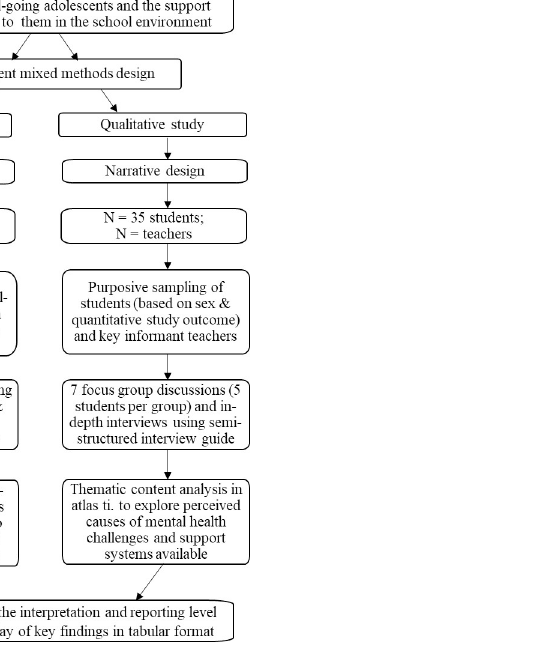
Fig 1. The convergent mixed-methods procedure used in this